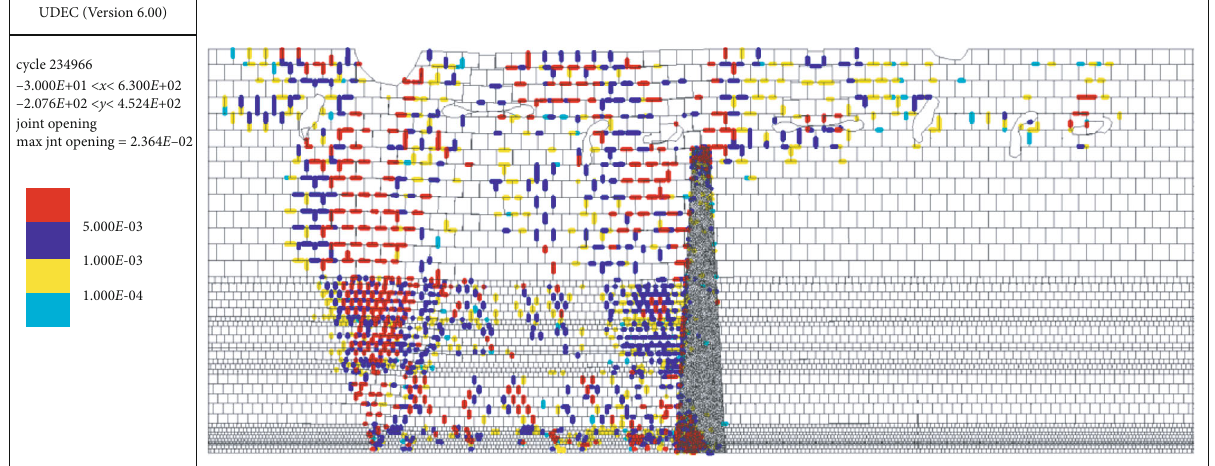
Figure 7: The mining-induced fracture fi eld (the mining distance is 300m).